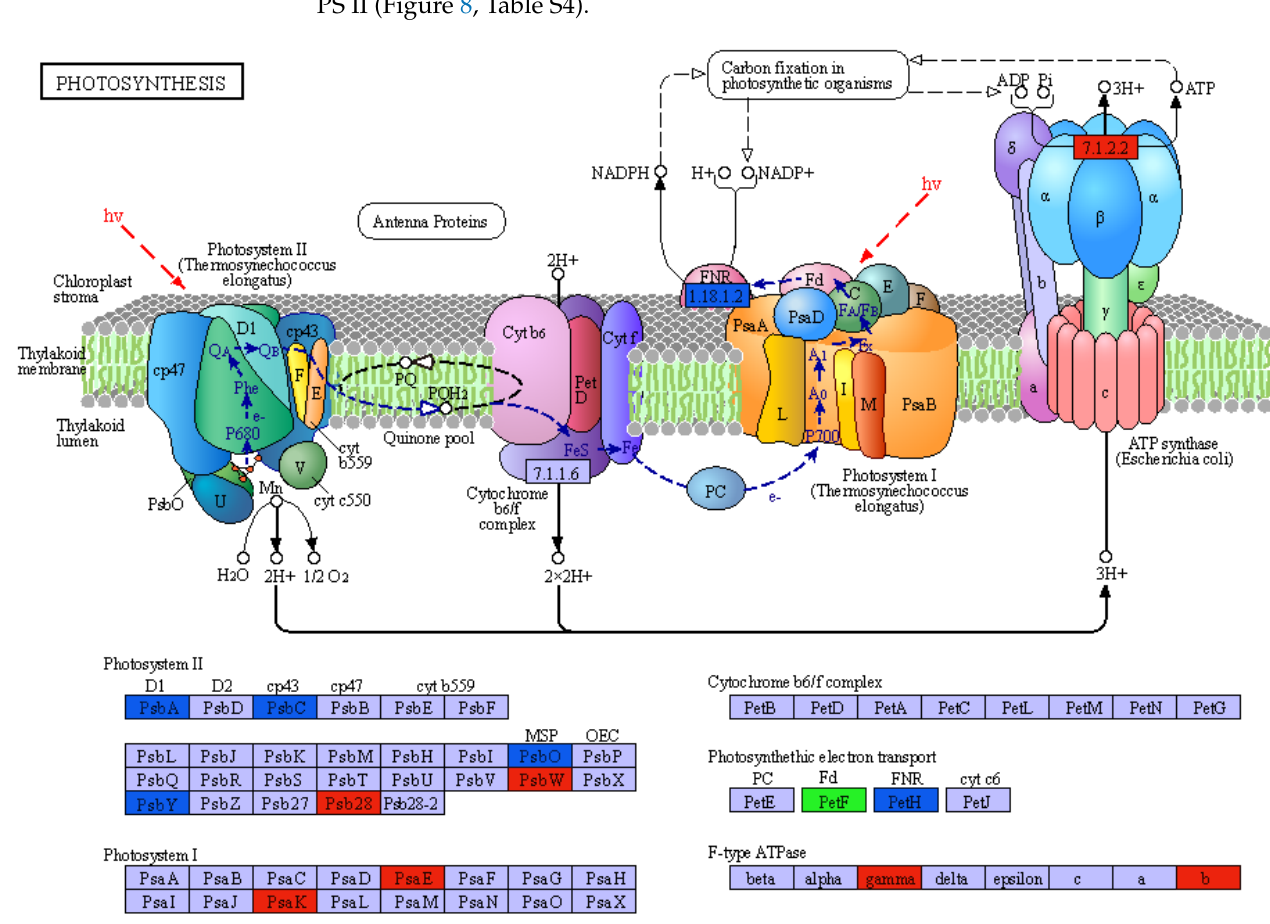
Figure 8. KEGG map of the photosynthesis pathway. Blue and red boxes indicate the specific steps that the DEGs in cmh15 and CM37, respectively, were involved in. The green box indicates that DEGs in both CM37 and cmh15 were involved in this step.